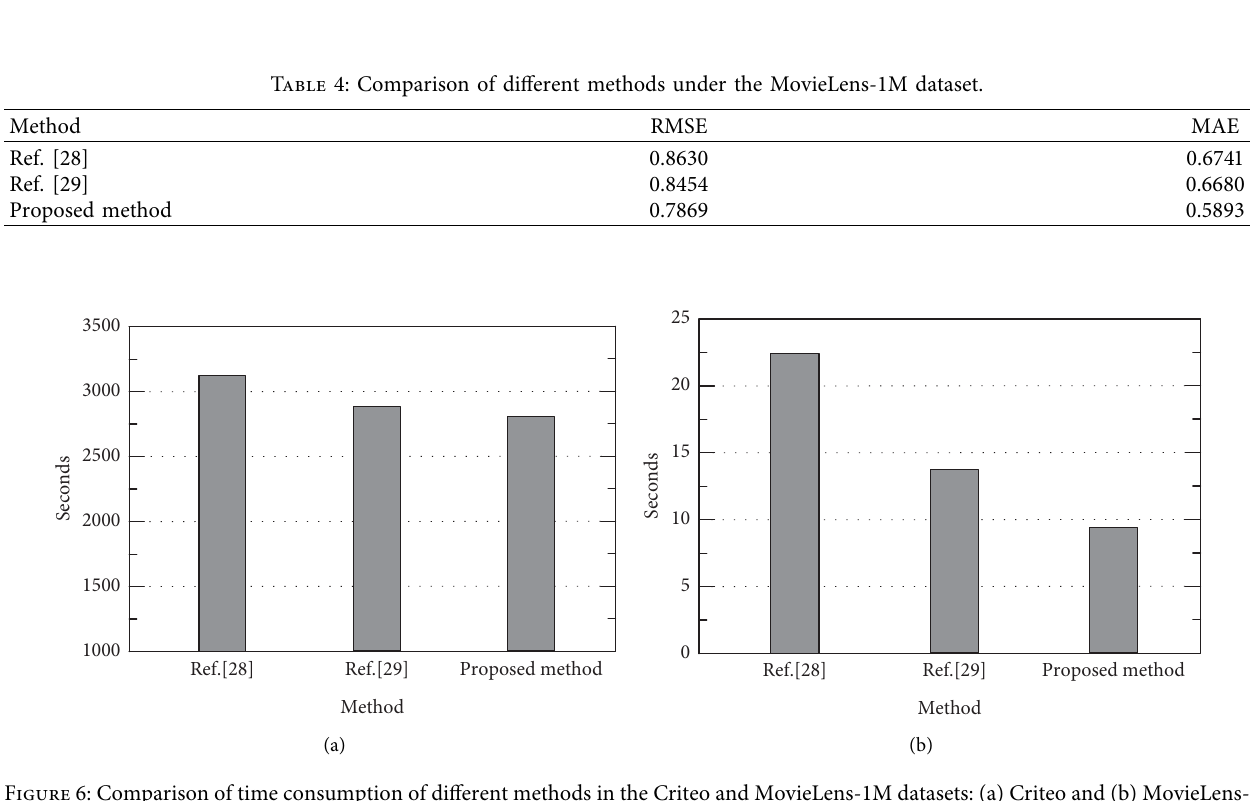
Figure 6: Comparison of time consumption of diferent methods in the Criteo and MovieLens-1M datasets: (a) Criteo and (b) MovieLens-